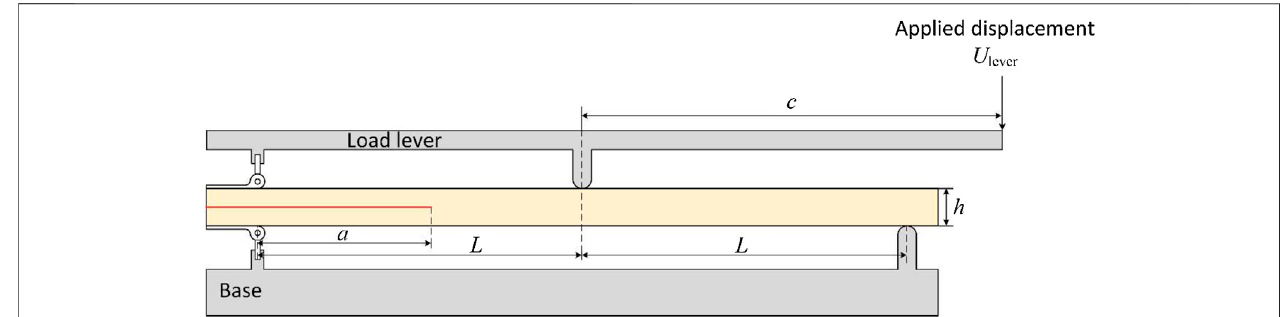
FIGURE 1 | Apparatus of the MMB